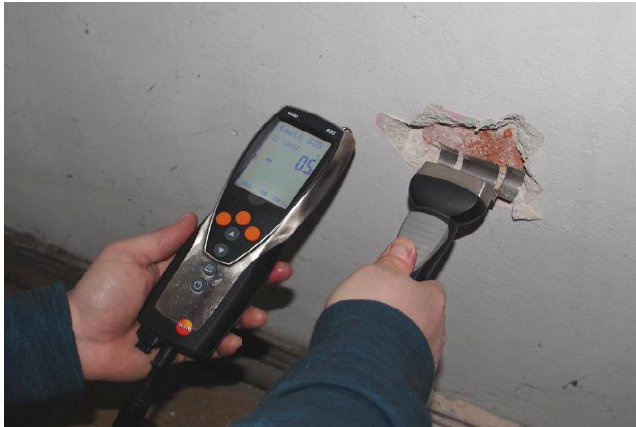
Figure 6. Mass moisture measurement in selected areas within the building.